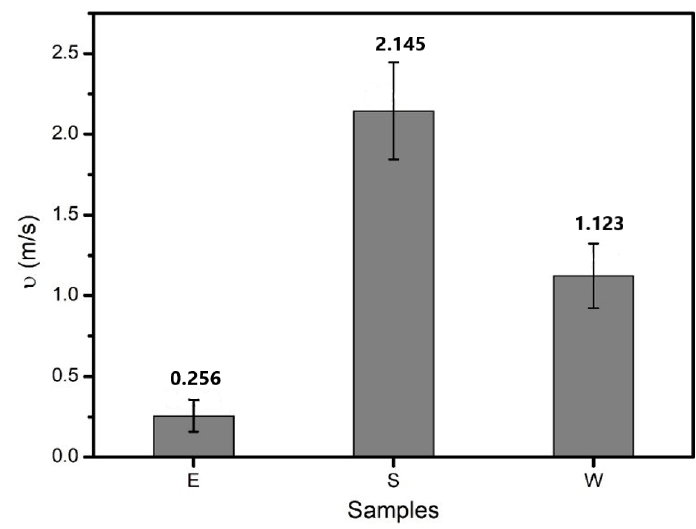
Figure 8. Wetting rate of the three kinds of healing agents.